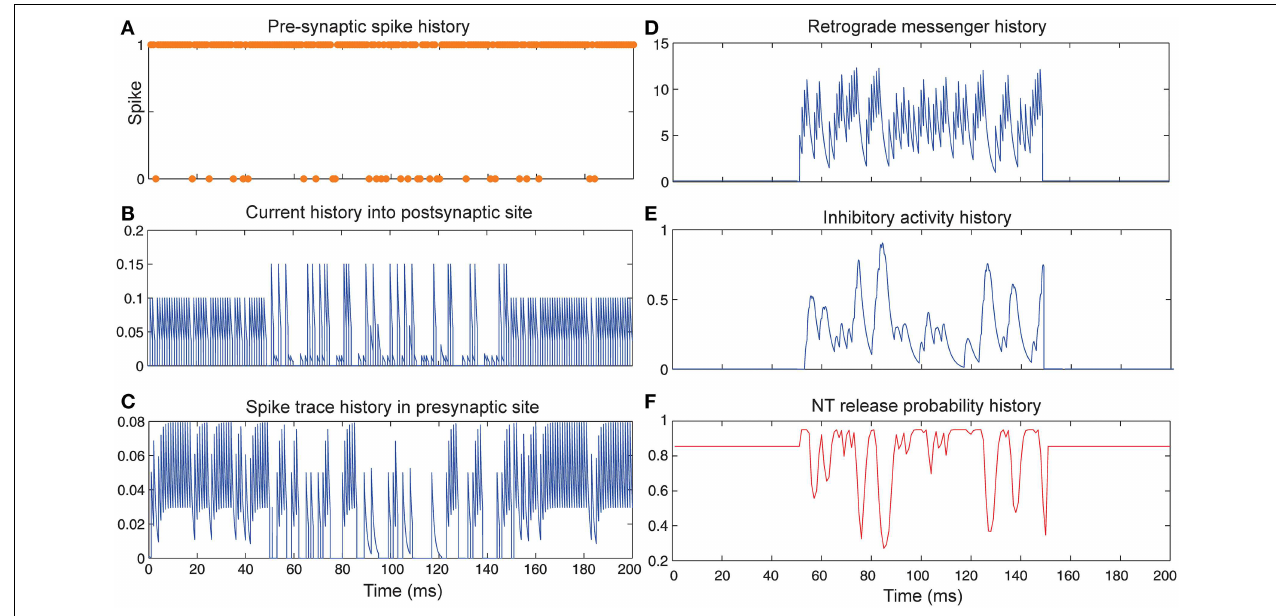
FIGURE 5 | The Dynamics of model’s parameters in the presence of homeostatic regulation of neurotransmitter release and Hebbian mechanism. (A) Spike train history of a presynaptic neuron with firing probability equal to 0.85 in 200 time bins. (B) Current history into the postsynaptic site triggered by the presynaptic neuron’s spiking. In time bins between 50 and 150 homeostatic regulation of neurotransmitter release was applied by generation of retrograde messenger in the postsynaptic site and its effect in the presynaptic site.